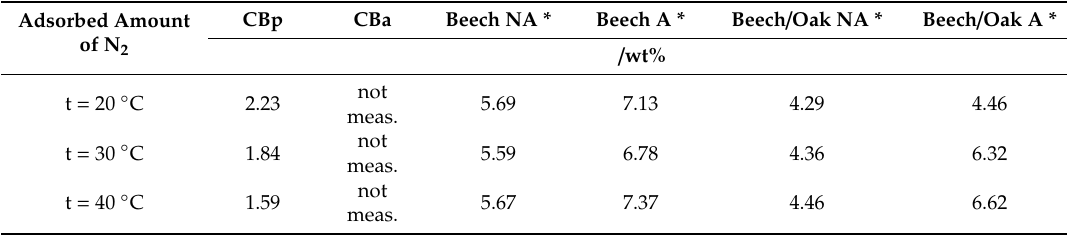
Table 3. Results of sorption capacity in the environment of N 2 at a pressure of 4000 kPa, comparison of experimental and literature data